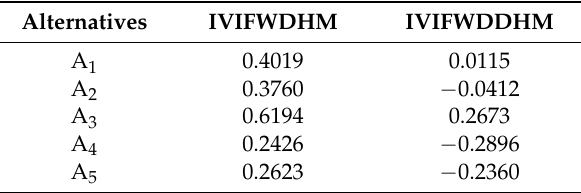
Table 3. The score values of tourism scenic